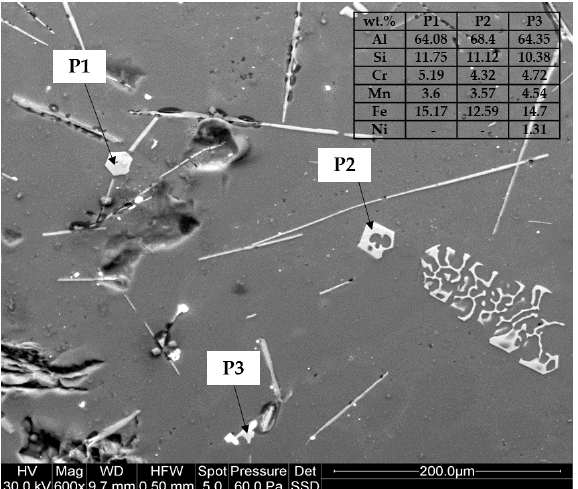
Figure 8. SEM+EDS analysis of alloy 16.